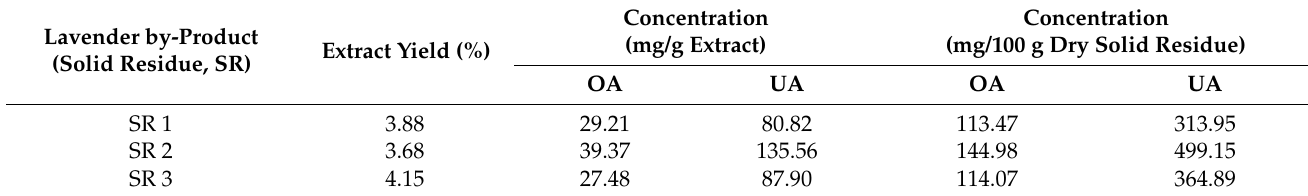
Table 4. The OA and UA content of lavender by-product (solid waste residue),